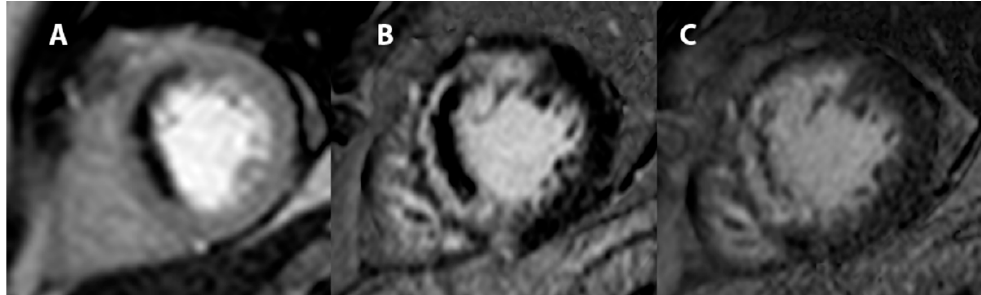
Figure 12. Cardiac resonance magnetic (CRM) showing first-pass perfusion (30 s) ( A ), early enhancement (4 min) ( B ), and late enhancement (15 min) ( C ), demonstrating impaired coronary microcirculation.